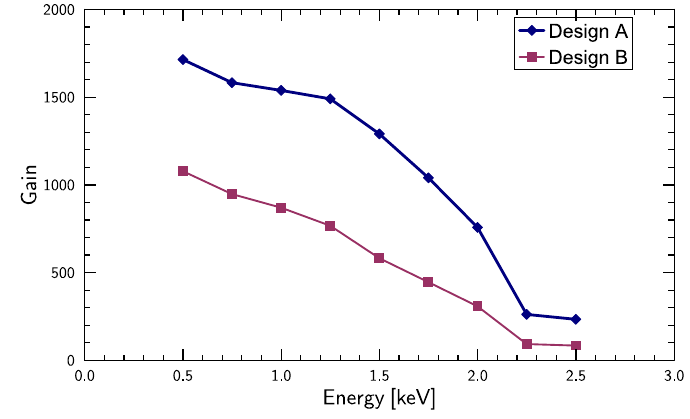
Fig. 4. Dependence of gain G on photon